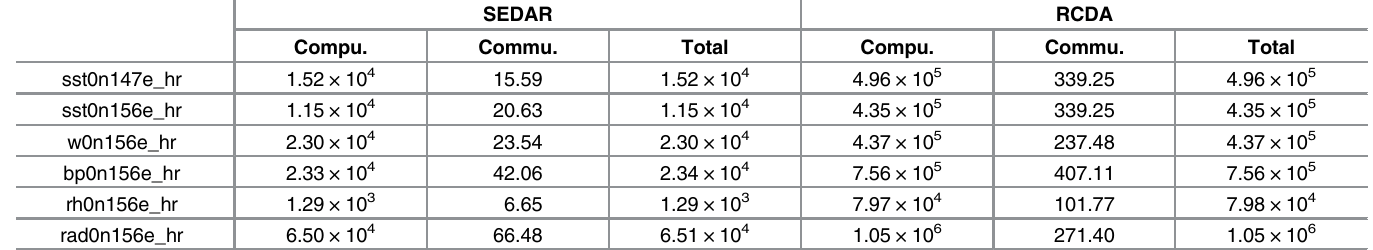
Table 5. Comparison on end-to-end aggregation time (unit: ms; N = 1000; cluster-based network. Compu.: computation delay; Commu.: communica- tion delay; Total: total delay). SEDAR RCDA Compu. Commu.